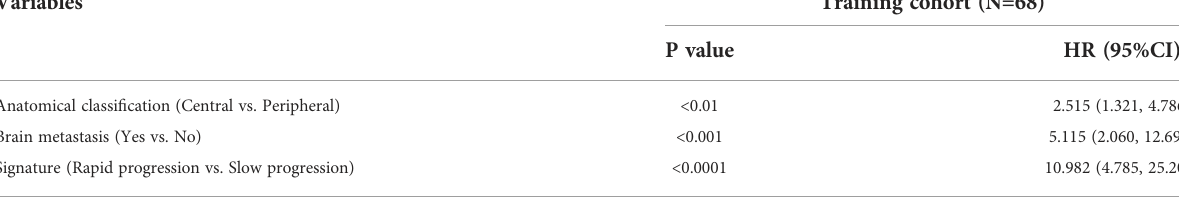
TABLE 2 Results of multifactorial Cox regression analysis of clinical variables and RFs in the training cohort. Variables